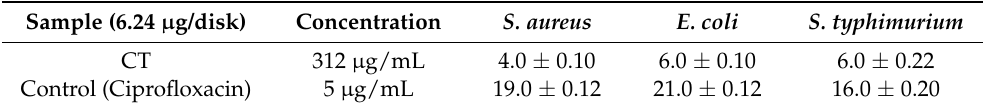
Table 3. The antibacterial properties of CT (diameter inhibition; mm).